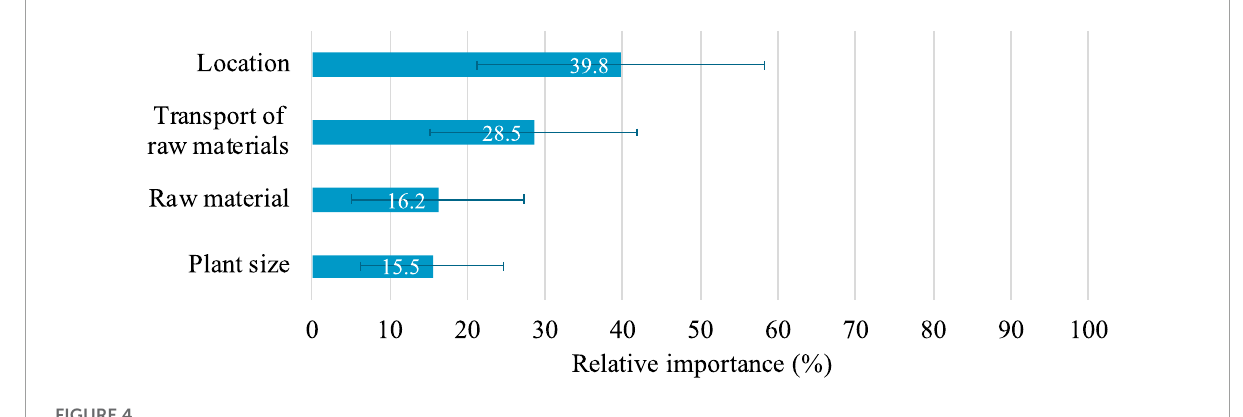
FIGURE 4 Relative importance of the attributes ( n = 303). Error bars indicate standard deviations.